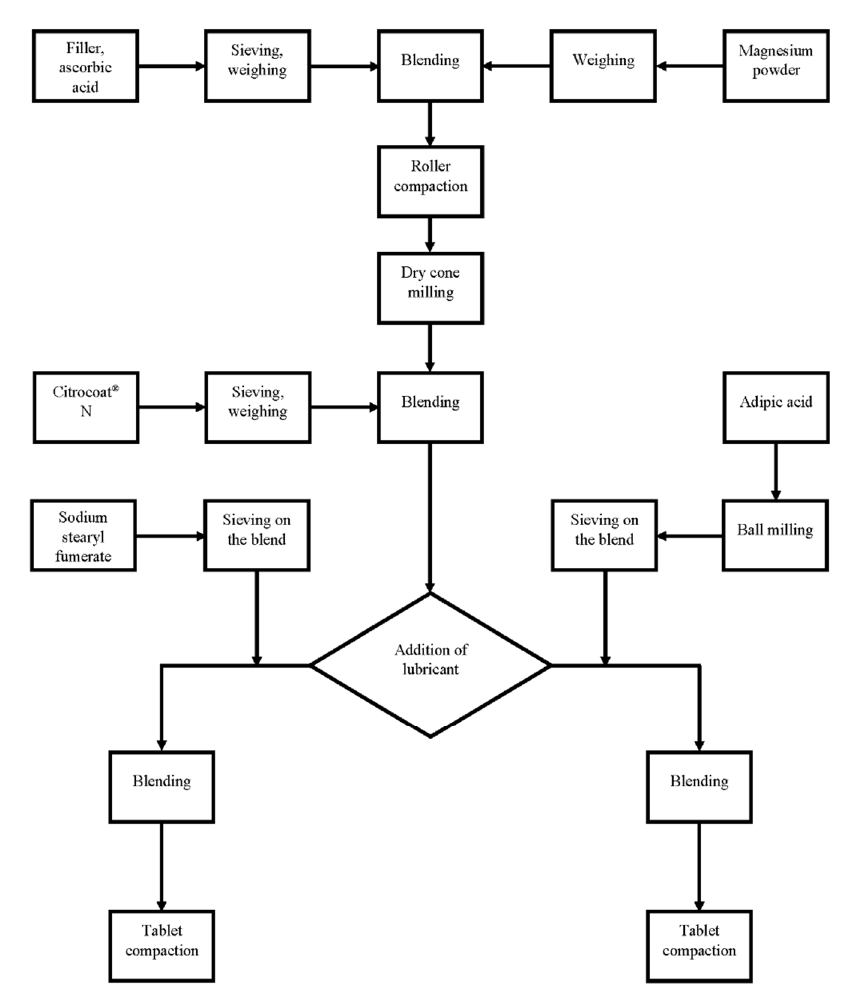
Figure 9. Flow diagram of the manufacturing